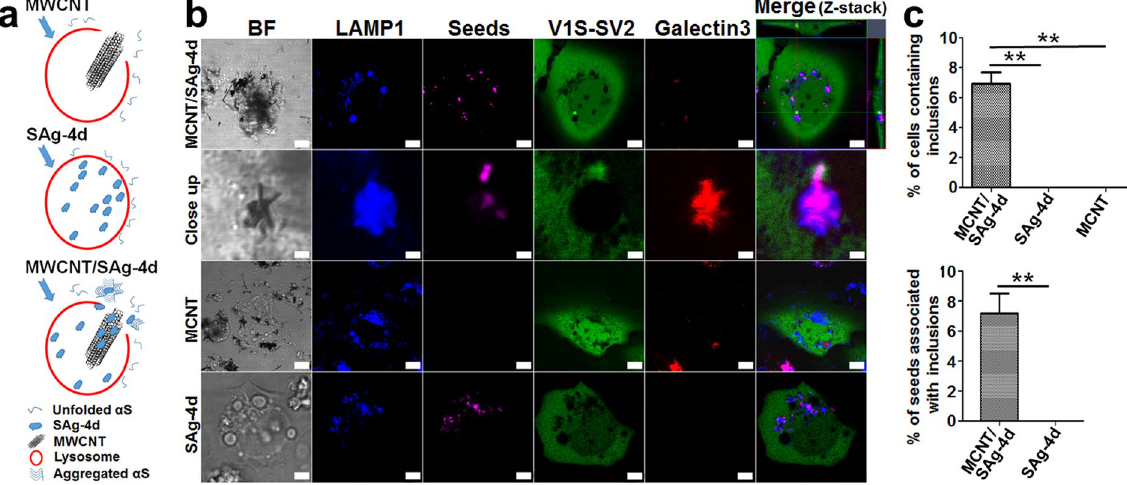
Figure 6. MWCNT partially recovers seeding activity of SAg-4d via induction of endo-lysosome rupture. (a) Schema of predicted effects of MWCNT on facilitating seeding of SAg-4d. (b) H4/V1S-SV2/LAMP1-eCFP/ mCherry-Galectin-3 cells were treated with the mixture of MWCNT and DyLight ® 650 labeled SAg-4d for 2 days followed by imaging under confocal microscopy. For controls, cells treated with MWCNT or DyLight ® 650 labeled SAg-4d alone were used. The framed areas in pictures of the first row (MCNT/SAg-4d) are enlarged and shown in the second row (Close up). Z-stack of images in MCNT/SAg-4d group confirmed the intracellular location of seeded α S inclusion. Scale bar: 1 µ m for the second row and 5 µ m for all the rest. (c) The comparison among MCNT/SAg-4d, SAg-4d and MCNT treated cells in the ratio of cells with inclusions to total cells is shown as the top bar-graph, and that between MCNT/SAg-4d and SAg-4d treated cells in the ratio of inclusions to total seeds shown as the bottom bar-graph. Error bars represent standard error of the mean ( * p < 0.05, ** p < 0.01, comparing subsets linked by line, n = 3).